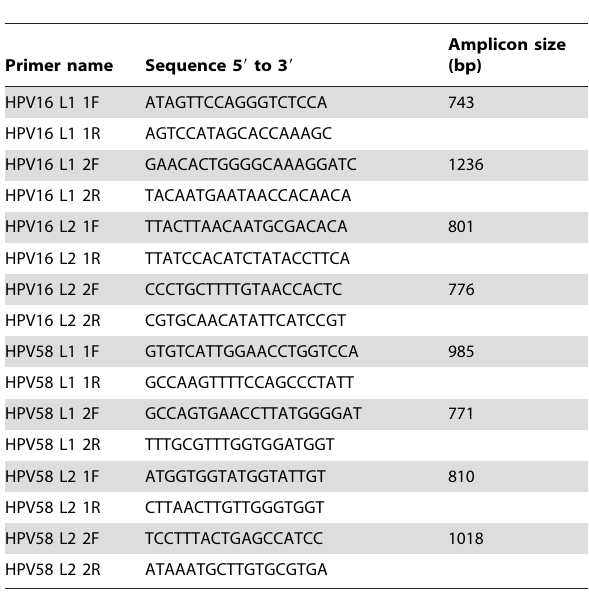
Table 1. Primers used for the molecular characterization of HPV-16 and HPV-58 L1 and L2.